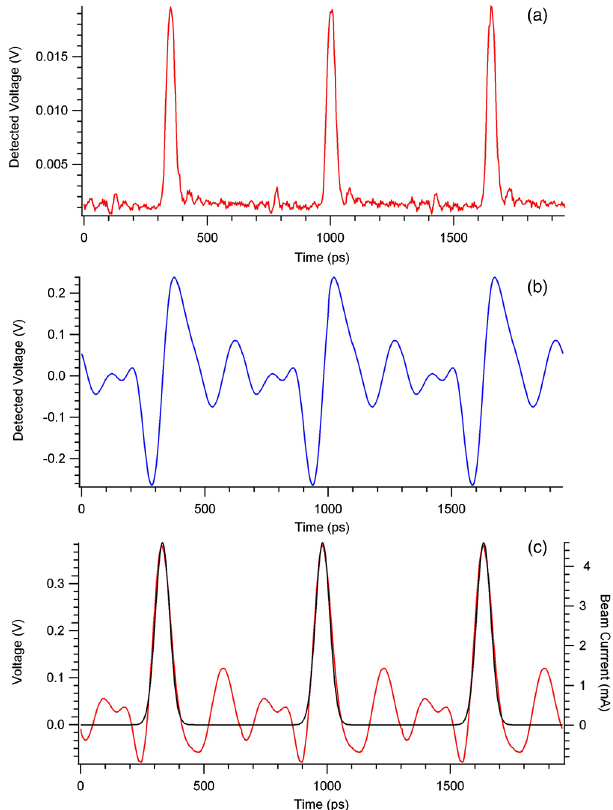
FIG. 4. Oscilloscope traces of (a) the drive laser optical pulse train, (b) the cavity bunch-length monitor, and (c) the FFT of signal from the cavity bunch-length monitor together with an overlaid Gaussian fit.